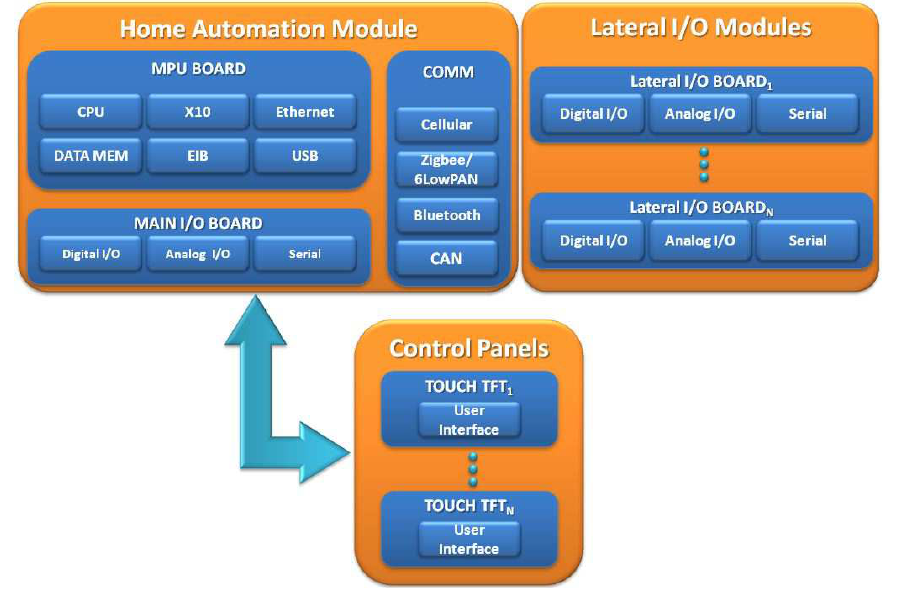
Logical diagram of the home automation module and its communication